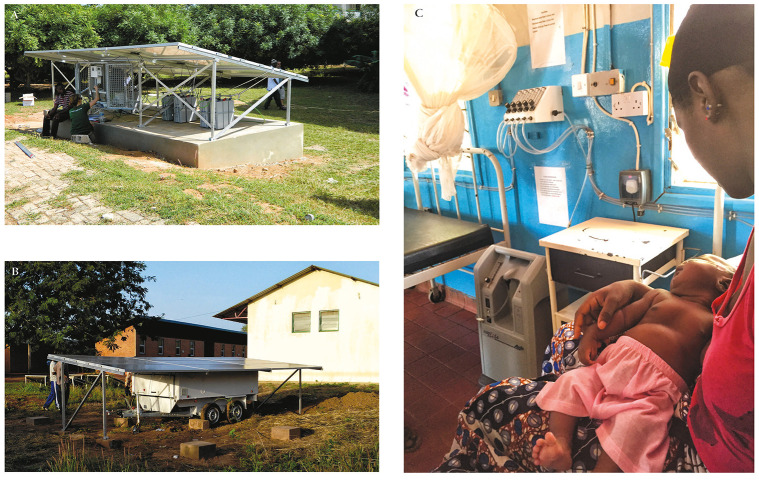
Solar-PS systems in the field. Panel A: Standard Solar-PS systems in situ in AFPRC Hospital, Farafenni, The Gambia. Panel B: Trailer Solar-PS system installed at Soma Health Centre, Soma, The Gambia.*Wheels were subsequently removed and fence erected to deter theft. Panel C: Trailer Solar-PS system supplying oxygen to a child in Soma Health Centre, Soma, The Gambia. *Photograph used with permission of caregiver.